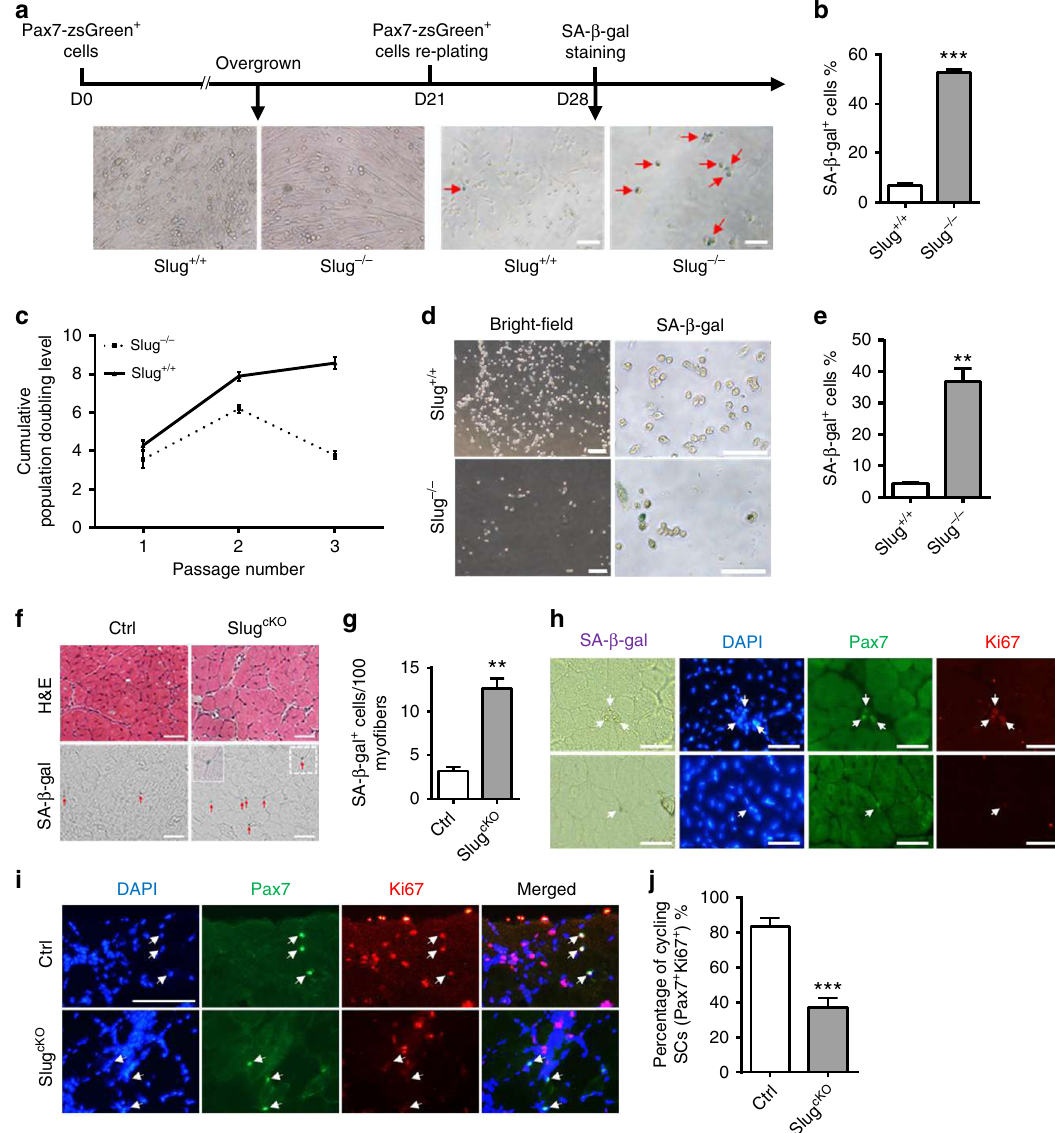
Fig. 5 Slug -de fi cient SCs acquire senescence properties during self-renewal. a SA- β -Gal staining. SCs of indicated genotype were differentiated for 21 days. 5000 zsGreen + reserve cells were sub-cultured for another 7 days and subject to SA- β -Gal staining. Red arrows indicate SA- β -Gal + cells. Scale bar, 100 µ m. b Quanti fi cation of the percentage of SA- β -Gal + cells stained in a . *** p < 0.001 by student ’ s t -test. c Cumulative population doubling level (CPDL) obtained in cultures of primary SC-derived myoblasts from Slug + / + and Slug − / − mice. d Photographs (left) and SA- β -Gal staining (right) of SC-derived myoblasts on day 7 of culture at passage 3. Scale bar, 200 µ m (left); 100 µ m (right). e Percentage of the SA- β -Gal + cells in d . ** p < 0.01 by student ’ s t -test. f Representative images of H&E (upper) and SA- β -Gal staining (lower) on transverse TA muscle cryosections. TA muscles from Slug cKO and Ctrl mice ( n = 3 per genotype) were harvested on day 10 post injury and subject to H&E and SA- β -Gal staining. Red arrows indicated SA- β -Gal + cells. The window (lower panel, right picture) represents high magni fi cation of dotted boxed area. Scale bar, 50 µ m. g Quanti fi cation of the SA- β -Gal + cell numbers stained in f . ** p < 0.01 by student ’ s t -test. h Senescent SCs in injured mice of Slug cKO and Ctrl mice. SA- β -Gal staining was combined with IHC staining against Pax7 and Ki67 on TA muscle cryosections being treated as described in f . Scale bar, 50 µ m. i IHC staining for Pax7 and Ki67 in TA muscle sections harvested at day 2.5 post the second BaCl 2 injury ( n = 3 mice per group). Arrows indicated SCs in the section. Scale bar, 100 μ m. j Percentage of cycling (Pax7 + Ki67 + ) SCs stained in i . *** p < 0.001 by student ’ s t- test. Data are presented as mean ± SEM of three independent experiments. Also see Supplementary Fig.